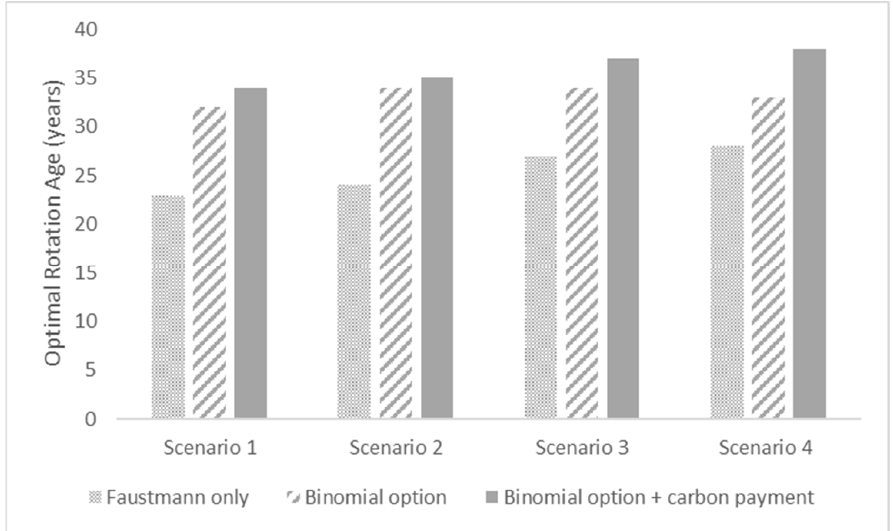
Figure 5. Optimal rotation age based on the Faustmann model, binomial option model and binomial option with carbon payment model.